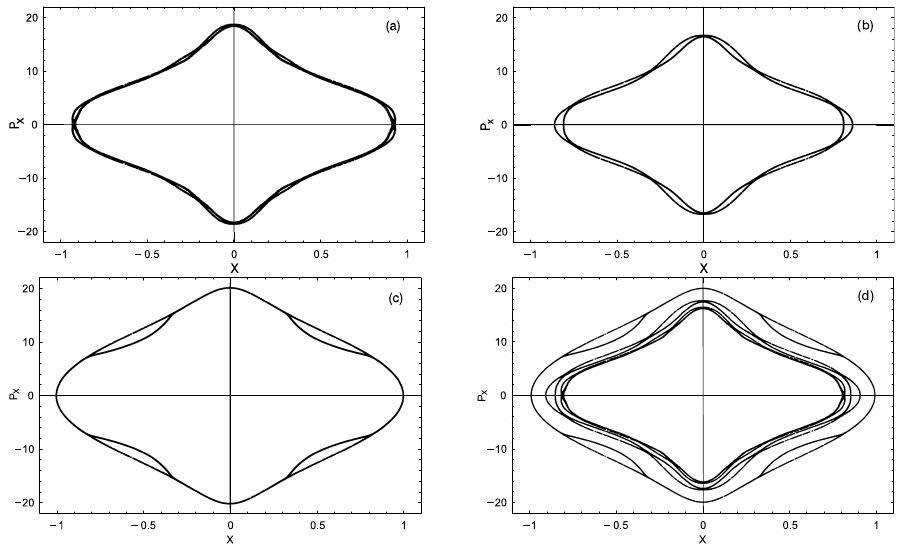
Fig. 4. Panels (a)–(c): the three chaotic components and panel (d): all the chaotic components together. the above regular orbit. The initial conditions are: x 0 = 0, y 0 = 0, p x 0 = 10 : 5. Here we observe three different spectra with a number of large and small